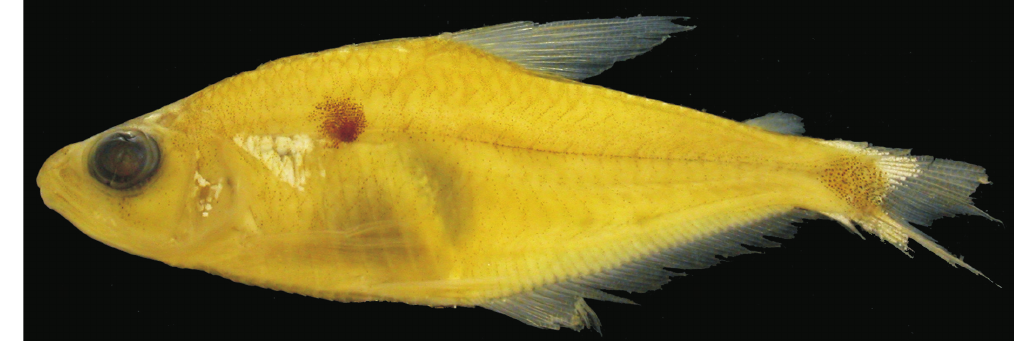
Figura 11. Phenacogaster simulatus sp. nov. , ROM 72774, holótipo, 43,2 mm CP, Rio Potaro, Guiana.